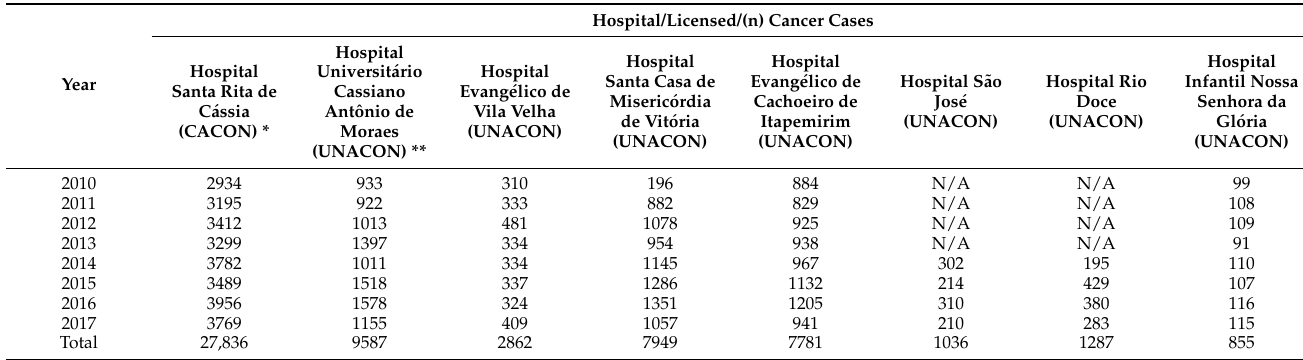
Table 1. Frequency of cases per year of the HCR of each hospital in the Oncology Care Network of the state of ES. Vit ó ria, ES, Brazil 2022 (N = 59,193